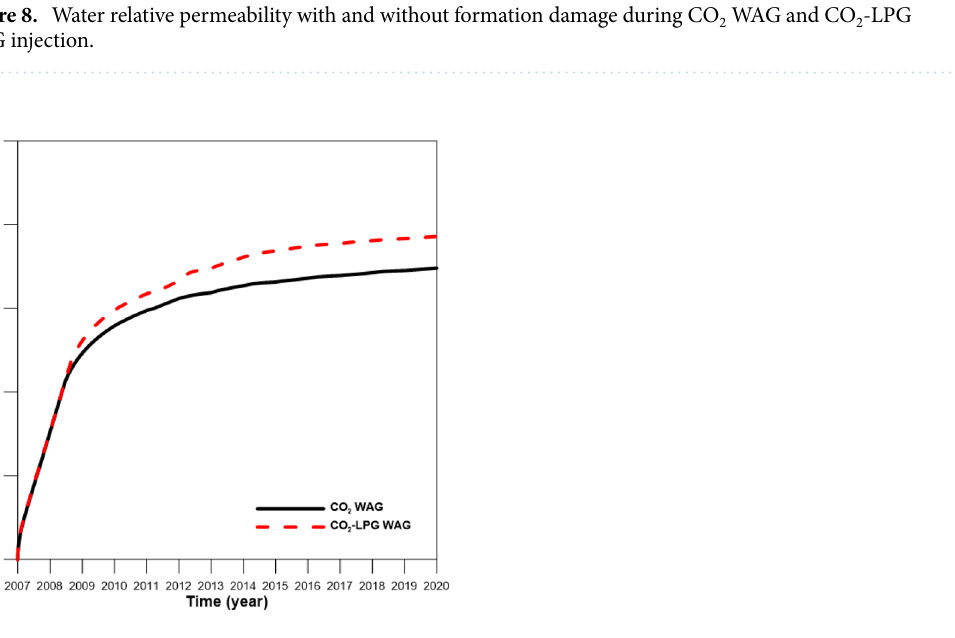
Figure 9. Oil recovery during CO 2 and CO 2 -LPG WAG